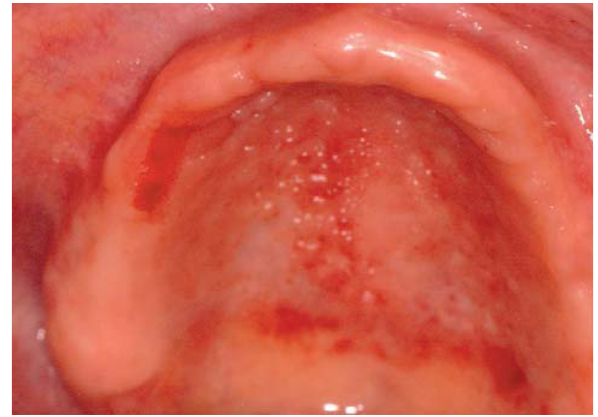
FIGURE 2- Papillary hyperplasia in the hard palate